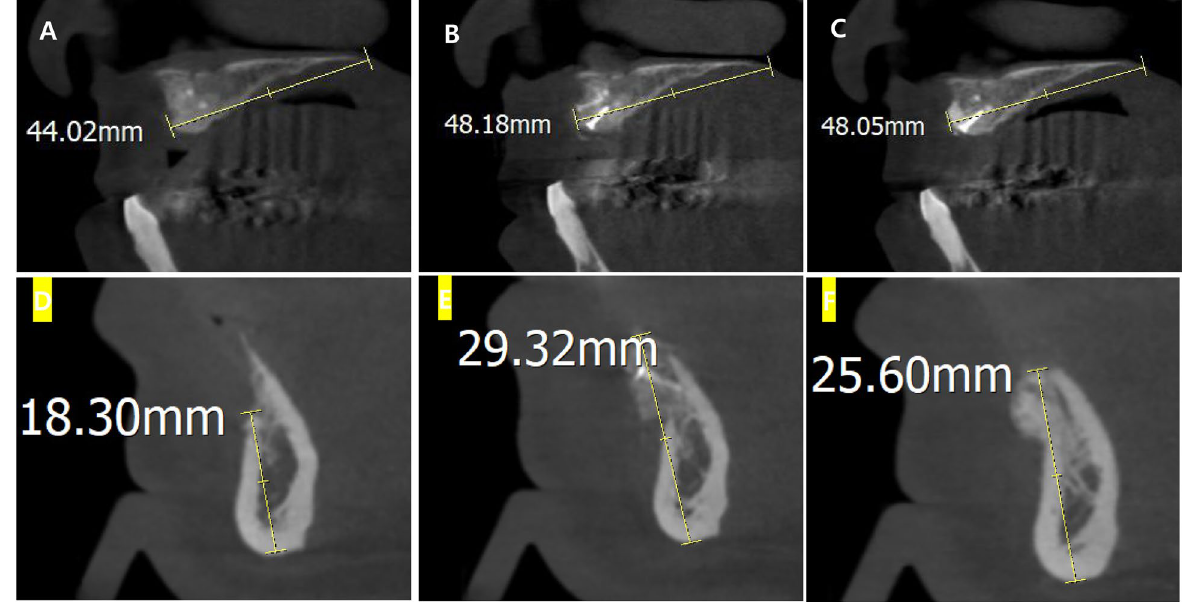
Fig. 2 Measuring the amount of increase in bone height or width at the graft site via CBCT. A and D Preoperative CBCT images. B and E Postoperative CBCT images right after surgery. C and F Postoperative CBCT images 6 months after